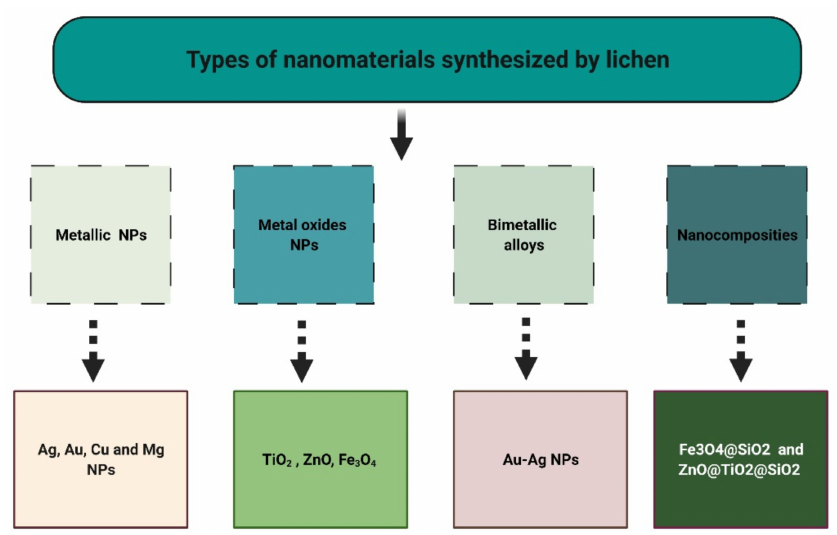
Figure 4. Types of nanoparticles (NPs) synthesized by lichen